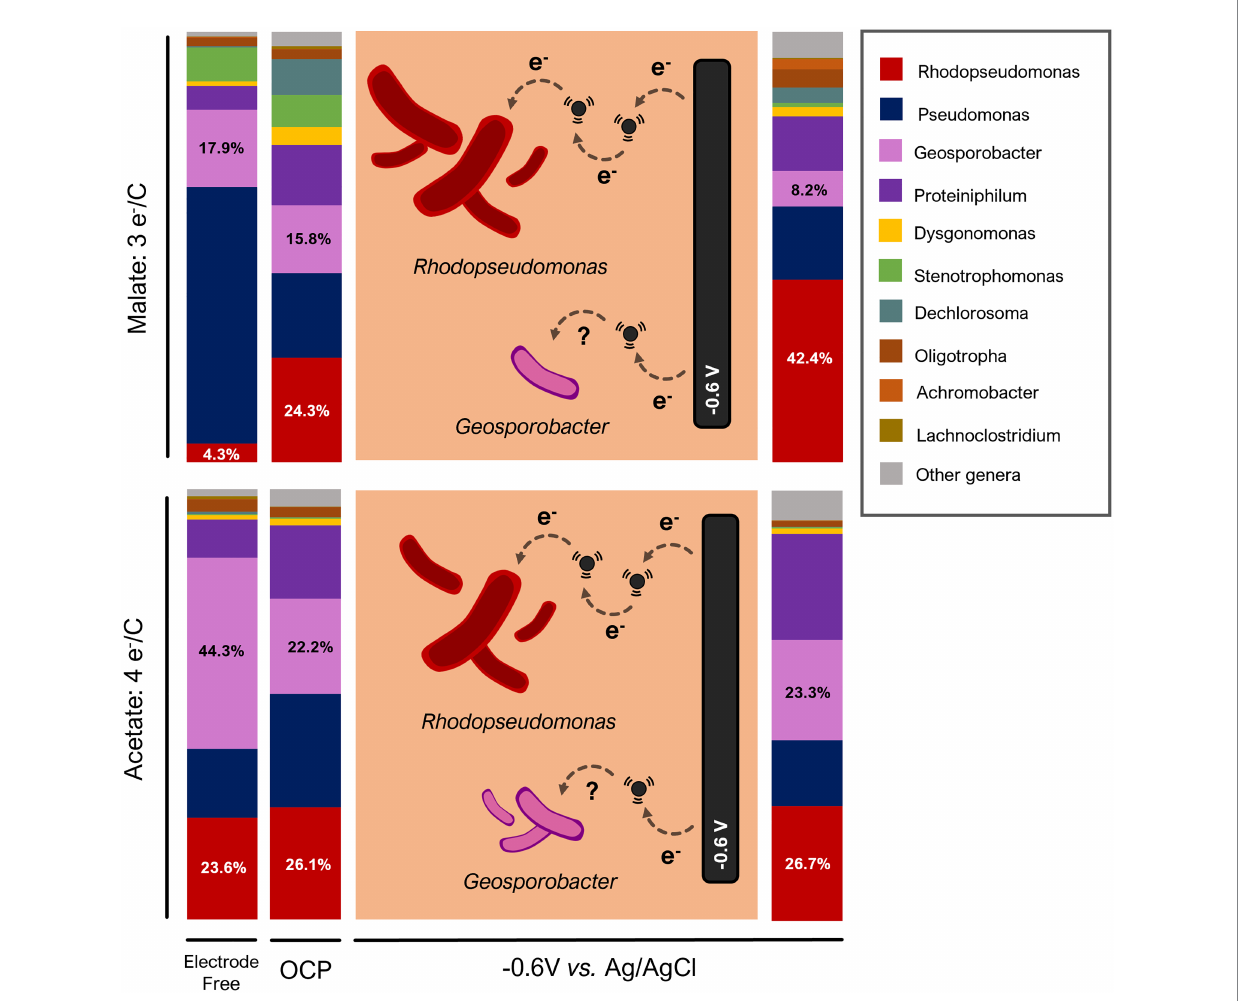
FIGURE 7 Genus-level composition (16S Illumina) of a microbial population grown with synthetic wastewater under fluid-like cathode IR-Irradiated